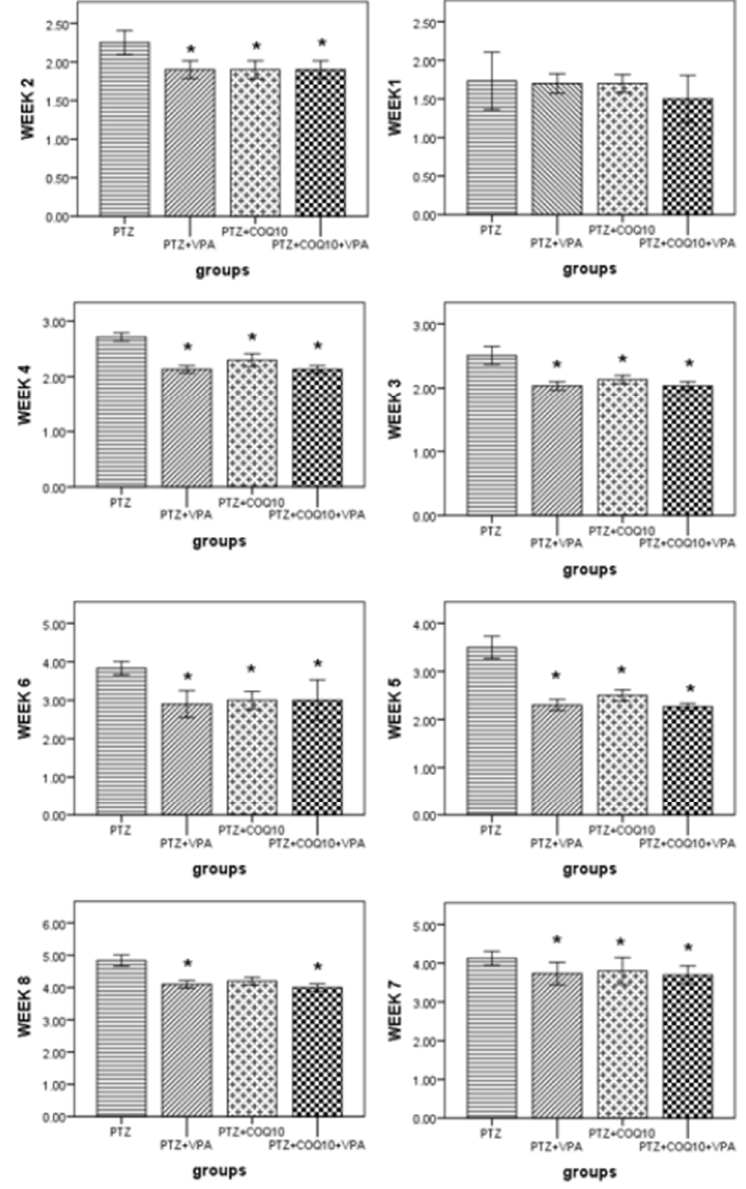
Figure 1. Effects of CoQ10 on the kindling course of Pentylenetetrazole. The data are expressed as the mean ± the standard error of the mean ( N = 6), one-way ANOVA, and a post hoc Tukey’s test. * p < 0.05 compared to PTZ alone group